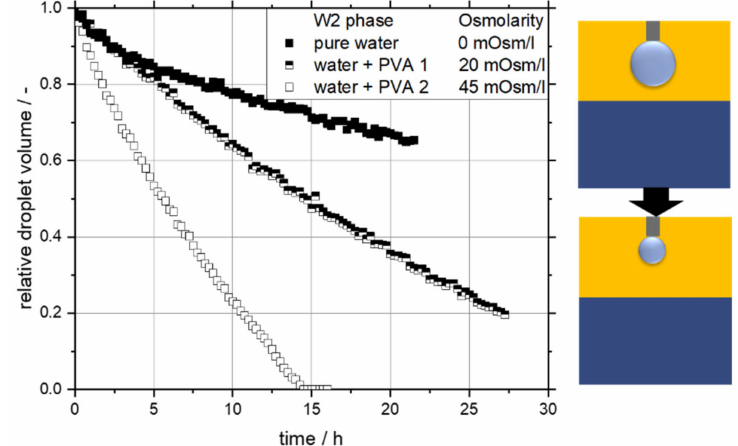
Figure 13. Shrinkage of a W1 droplet by di ff usion. In the outer water phase, di ff erent polyvinyl alcohols (PVA) were added as emulsifiers, changing both the osmotic pressure and the interfacial properties. The initial drop volume was 2 µ